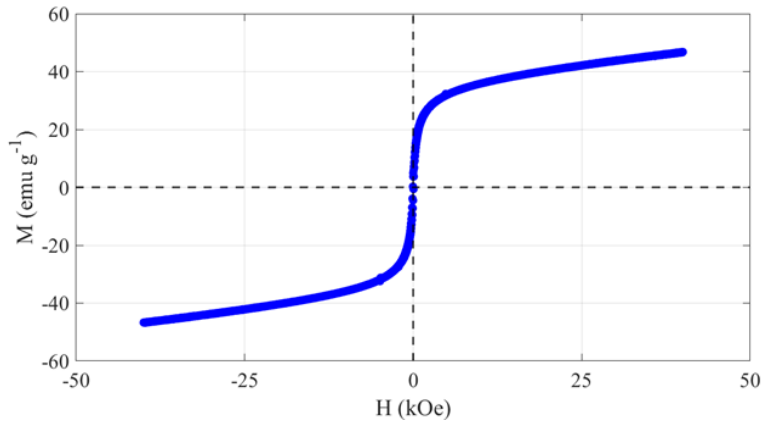
Figure 7. Magnetic hysteresis loop of the MNPs from VSM measurements.